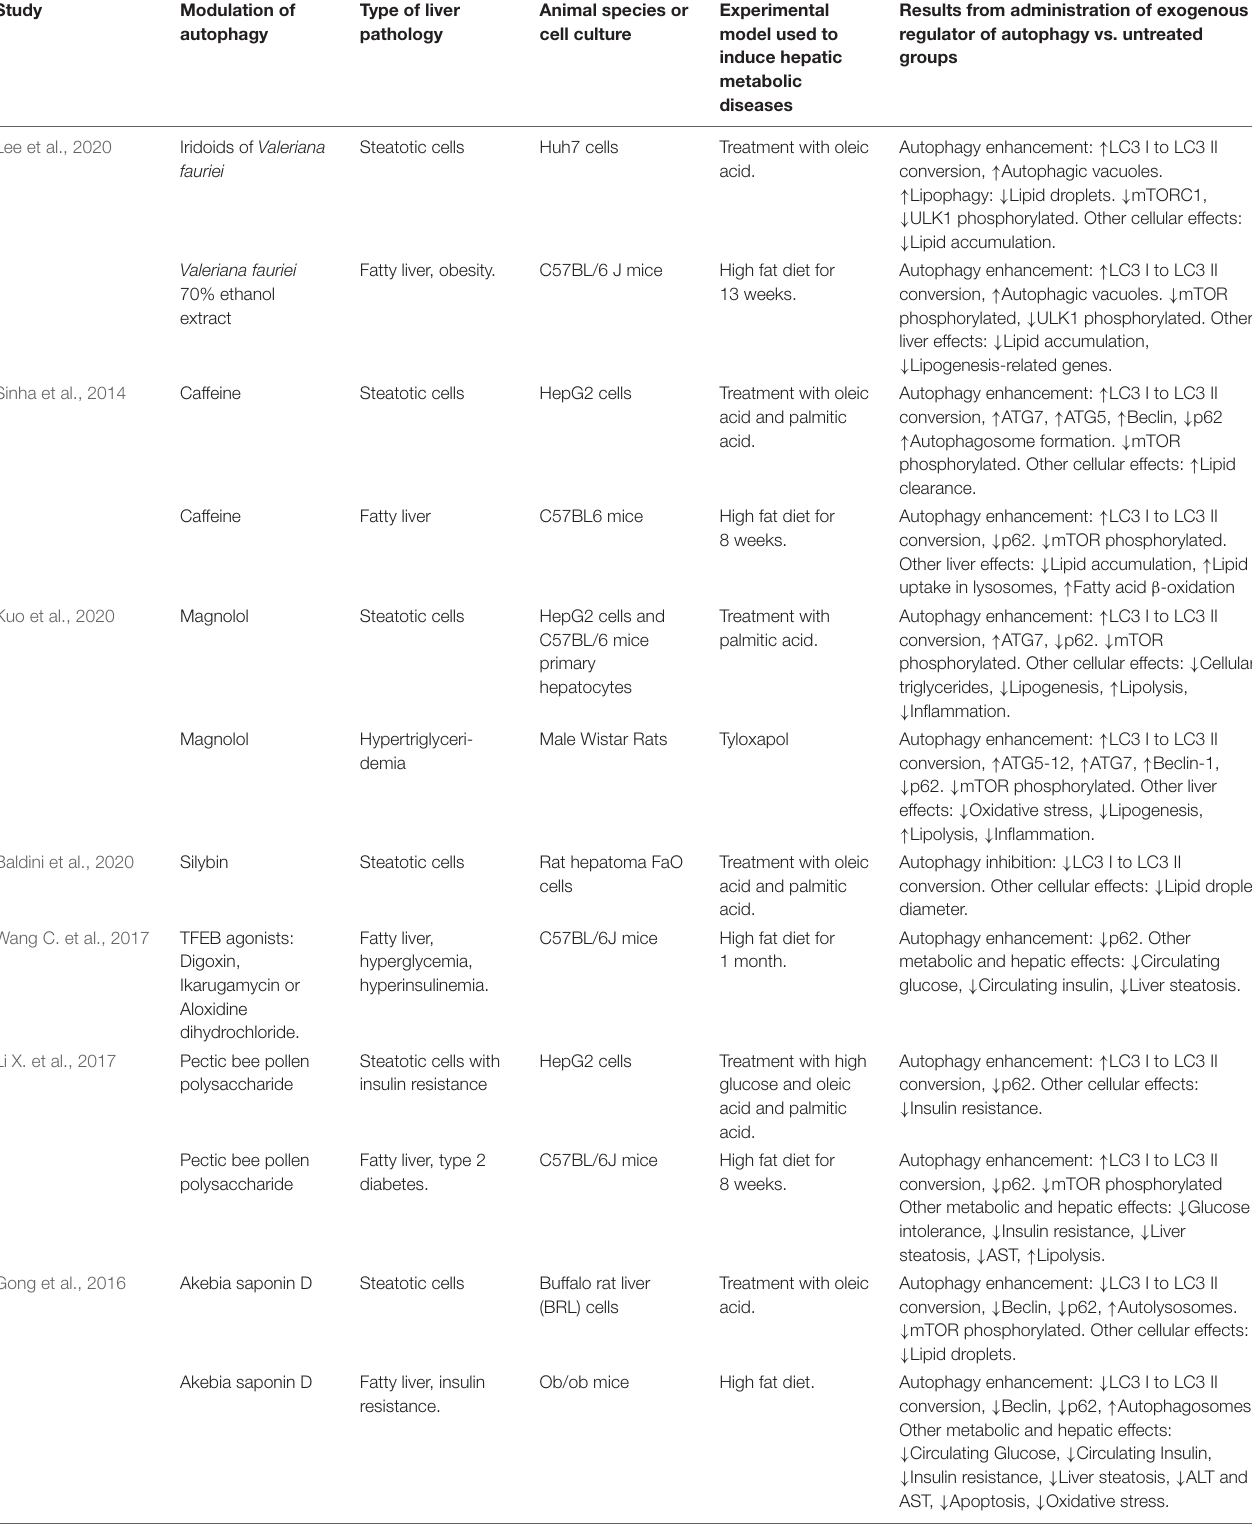
TABLE 3 | New promising autophagy regulators to be evaluated as therapeutical strategies in livers affected by metabolic diseases and submitted to surgery.